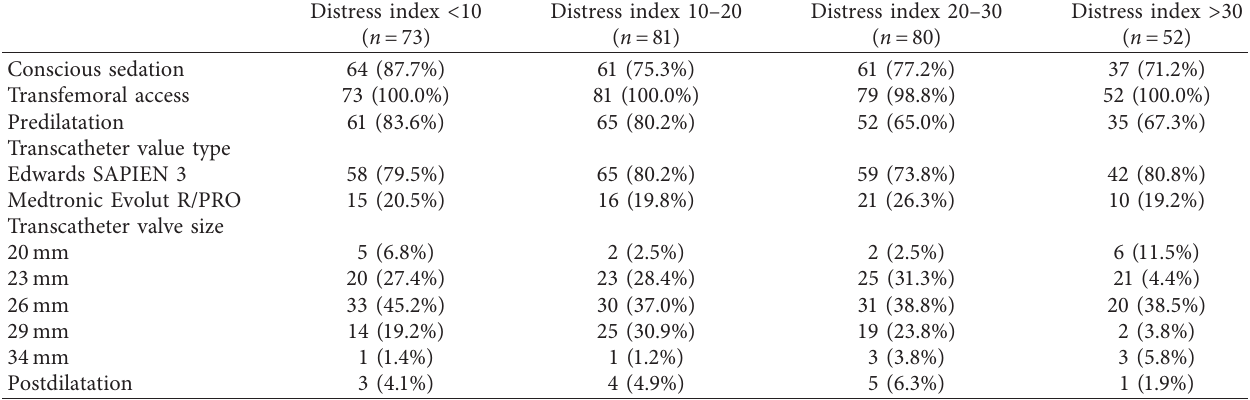
Table 3: Procedural information.